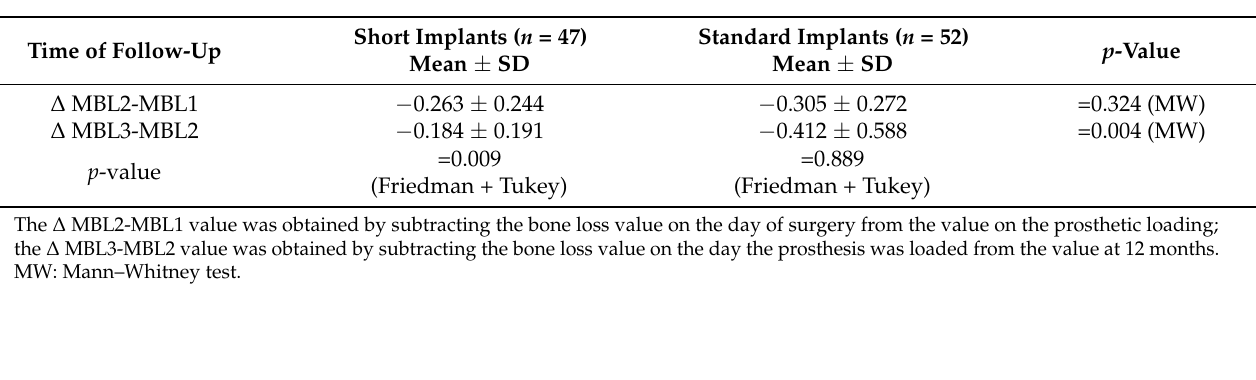
Figure 3. Average marginal bone levels (mm) in patients with standard implants ( ≥ 10 mm) and short implants (7 and 8.5 mm). Table 3. Comparison of the increases of the vertical distance from the implant shoulder to the most coronal aspects of implant–bone contact (MBL) (medial, mesial, and distal) between both study groups at the two follow-up time